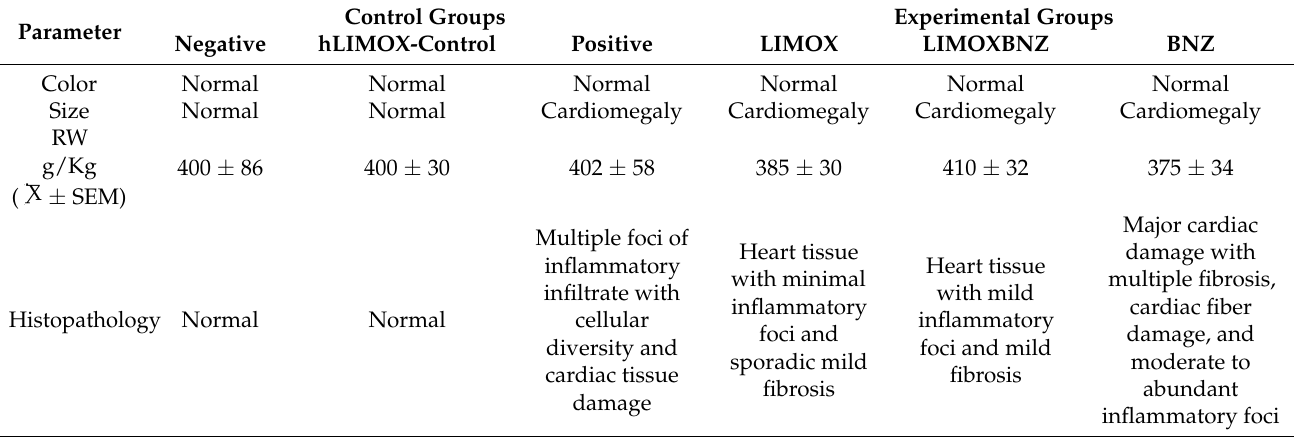
Table 3. Macroscopic and microscopic findings in the hearts of Wistar rats after receiving treatments.